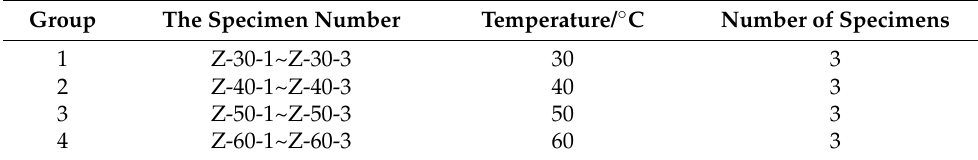
Table 1. Equilibrium moisture content test program.